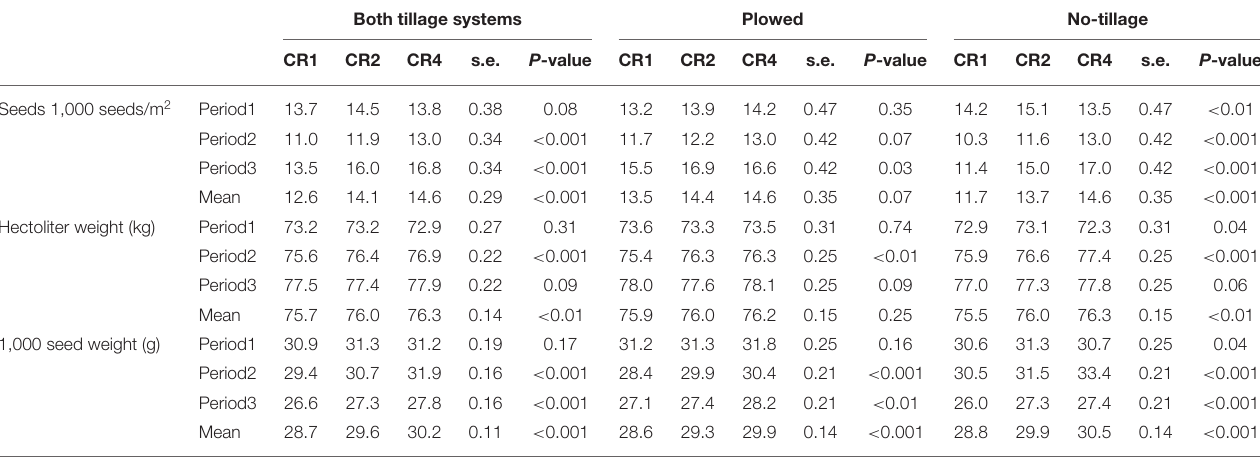
TABLE 3 | The average number of produced seeds (1,000 seeds/m 2 ), the hectoliter weight (kg), and 1,000 seed weight (g) in spring wheat in different tillage systems, time periods, and crop rotations.